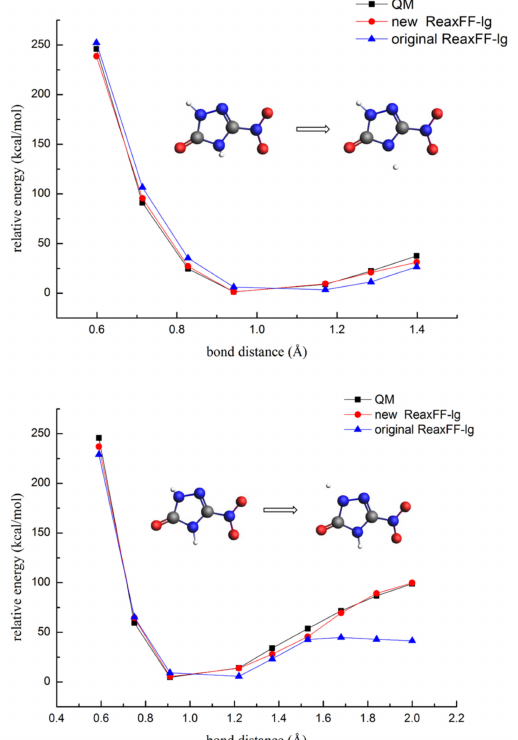
Figure 3. The dissociation energies for the two N-H single bonds at the skeleton ring of NTO (gray—carbon atom; white—hydrogen atom; red—oxygen atom; blue—nitrogen atom).